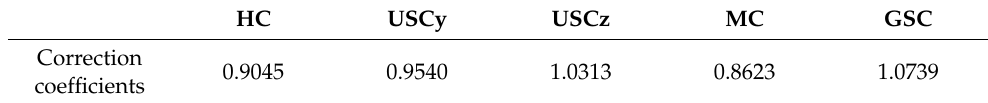
Table 3. Correction coefficients of the MNS.